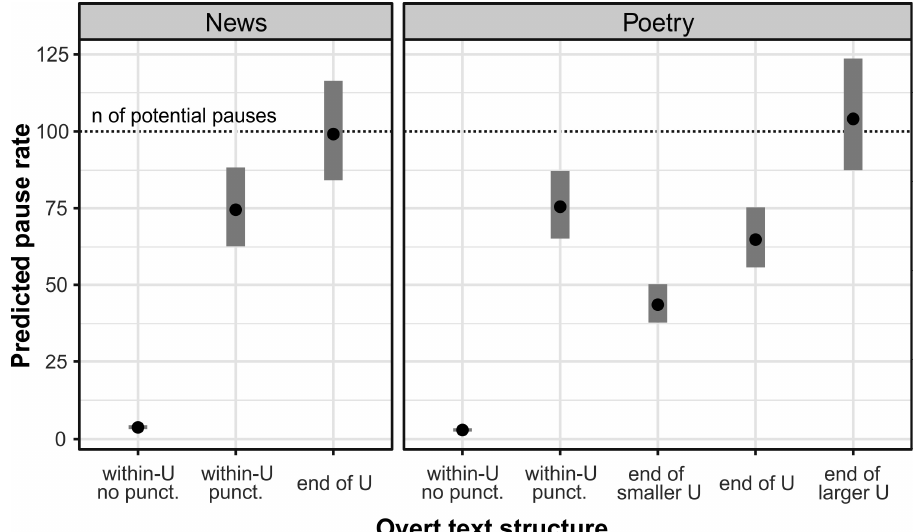
Figure 5. Predicted pause rate as a function of overt text structure (U = unit; punct. = punctuation). For an explanation of levels, see Section 2.3. The predictions of a Poisson regression model are back-transformed from log values to rates and relate to a sample of 100 potential pauses (dotted line).